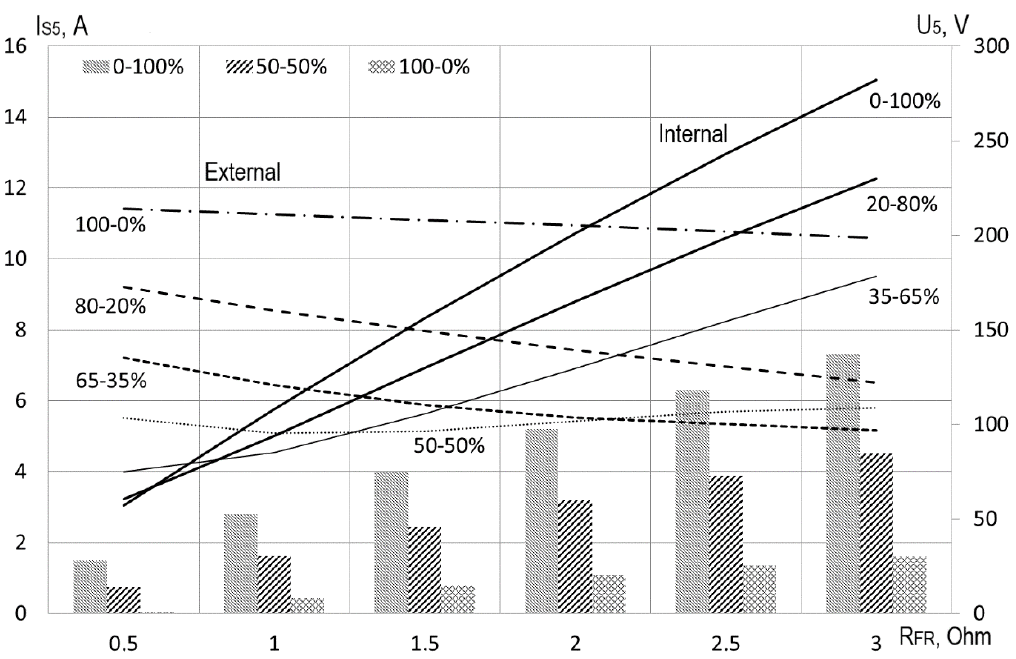
Figure 6. The dependences of the input harmonic current I S5 (line graph) and the harmonic voltage U 5 (bar graph) on the resistance of the harmonic filter for the first consumer.